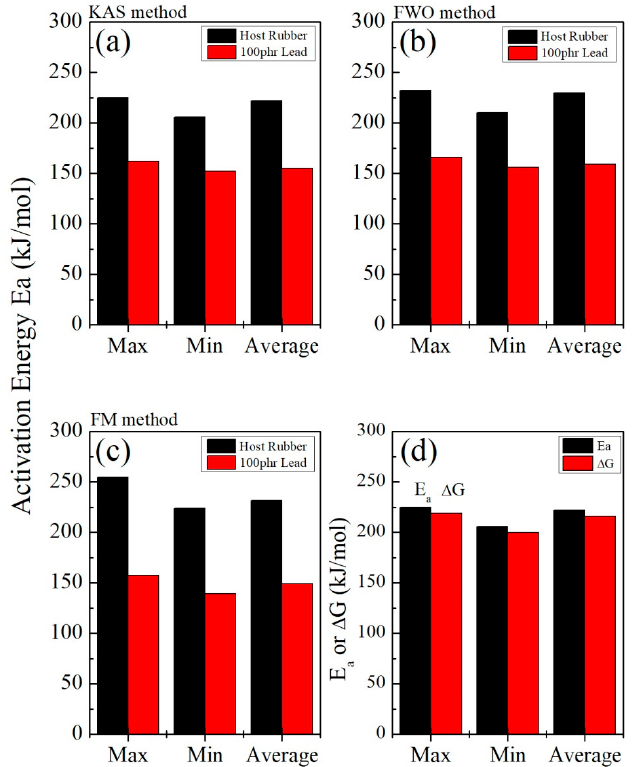
Figure 14. A comparison among the activation energy values of the host and lead-loaded EPDM rubber samples using the three methods ( a ) KAS, ( b ) FWO, and ( c ) FM, and ( d ) a comparison between the values of the activation energy, E a , and the change in the Gibbs free energy, ∆ G (for KAS, using the host rubber sample as an example).